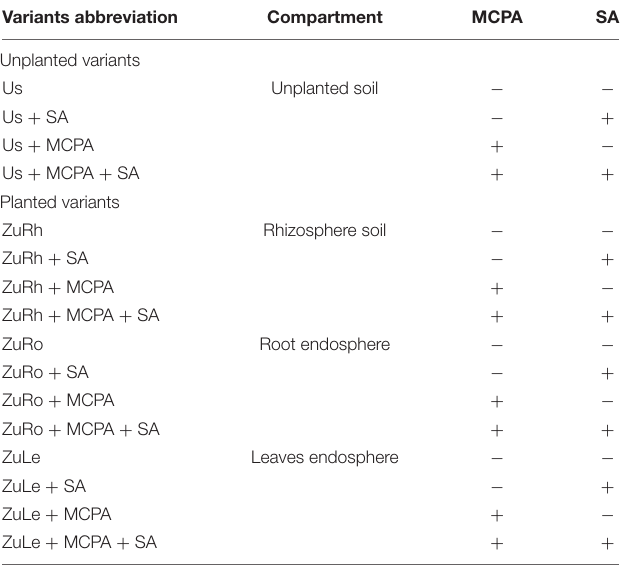
TABLE 1 | Abbreviations used for the different variants and their